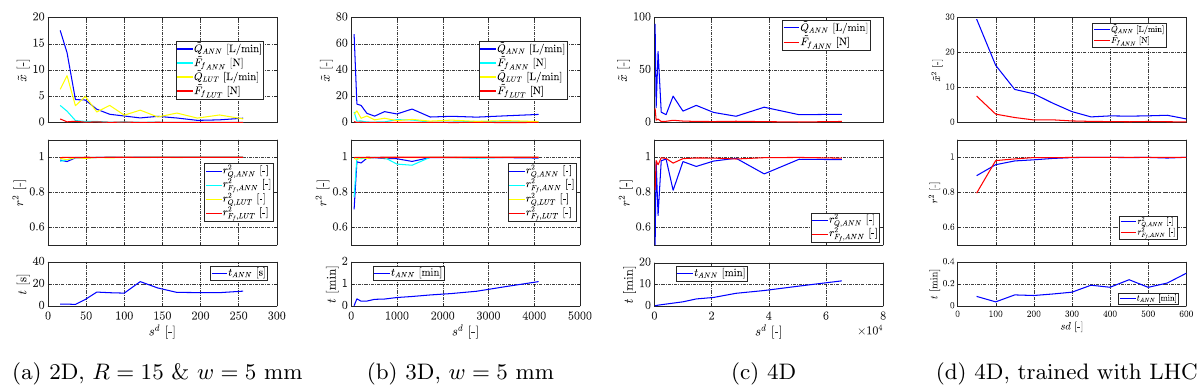
Figure 12: Relation between amount of samples s , residuals of flow and force (˜ x ) and the correlation coefficient ( r 2 ). The time periods required for training an ANN ( t ANN ) are shown in the bottom graphs (in second for 2D). The ANN structure is as shown in Figure 10 with l = 4, where each hidden layer has 14, 15, 5, and 16 neurons respectively. LUT denotes Look-Up Table surrogate and is not displayed for the 4D case. The improvements from using a LHC structure is visible in Figure 12d where samples are proportional to d not raised in d .